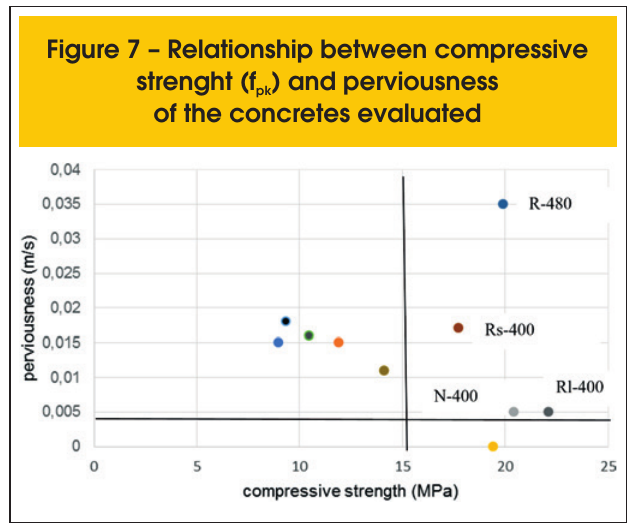
Figure 6 – Perviousness values of different concrete mixtures prepared with the same amount of cement